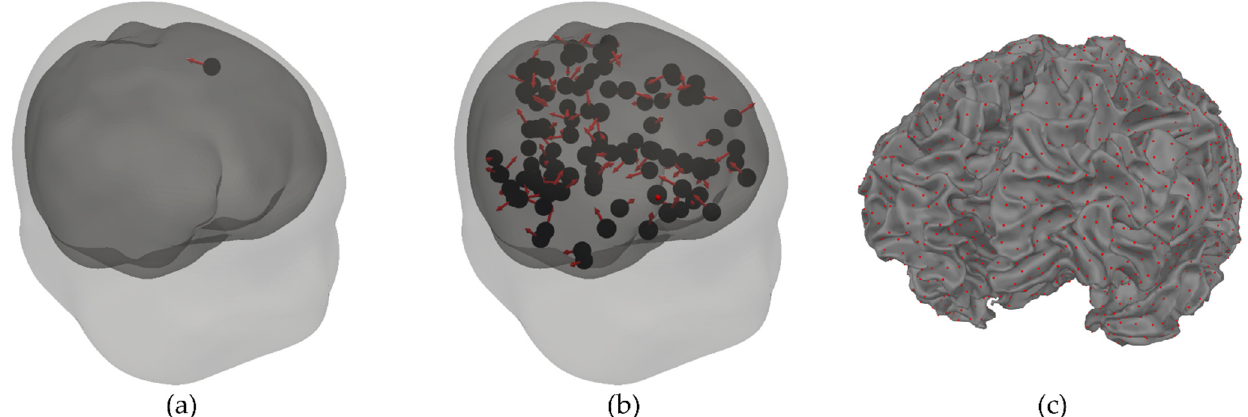
Figure 3. Examples of dipole locations and directions inside the brain. ( a ) Location and direction of one dipole for one sample time frame. The size of the red arrows does not represent the strength of the dipoles. ( b ) Locations and directions of 100 dipoles for simulated spontaneous brain activity for one sample time frame. ( c ) Example of the reconstructed brain surface (white matter) and all possible locations from which we chose the dipoles for the simulation (red dots).